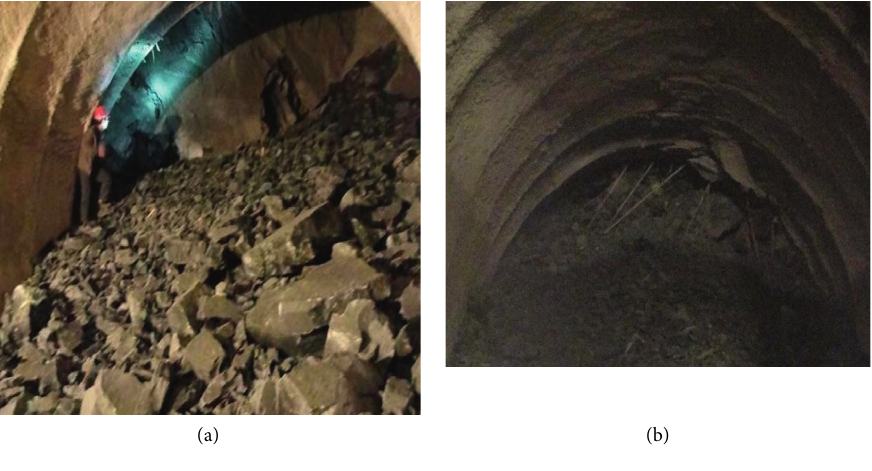
Figure 2: Collapse in excavation